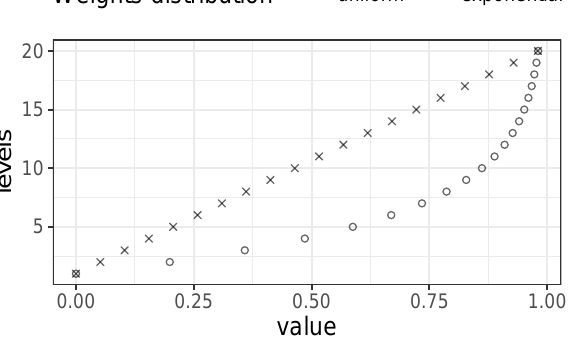
Figure 8. The 20 levels for a float parameter ( R ∈ [ 0,0.99 ] ) considering a uniform or an exponential weight distribution.